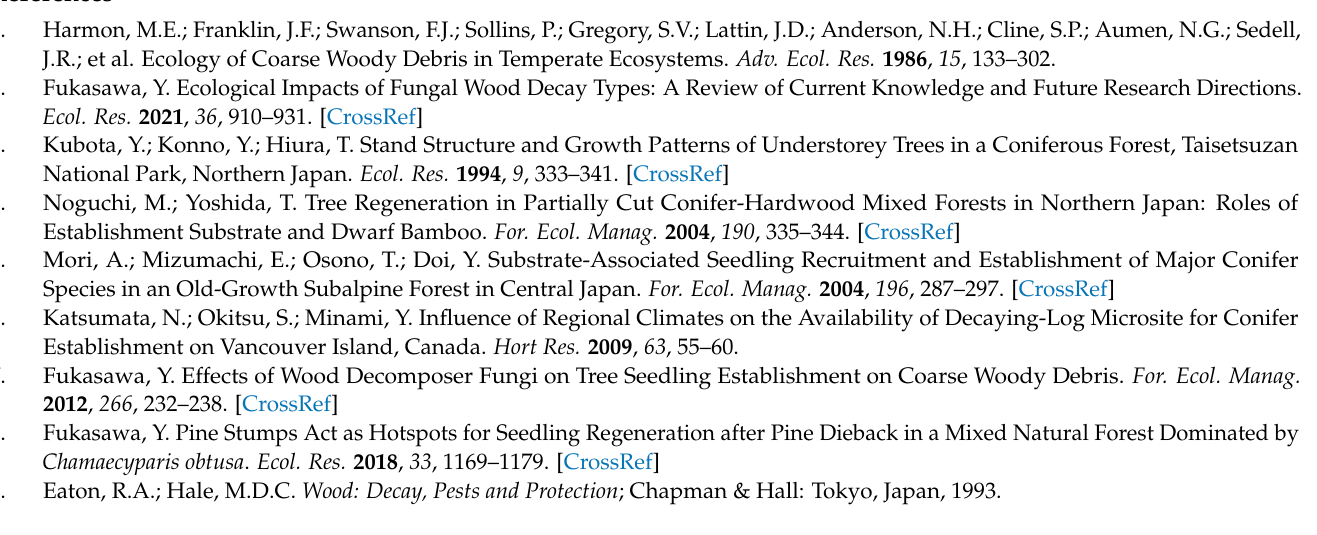
Figure S4: Seedling growth of the four tree species during 173 days on unsterilized and sterilized substrates; Table S1: List of fungal OTUs and their frequencies detected from ITS1 metabarcoding of DNA extracted from